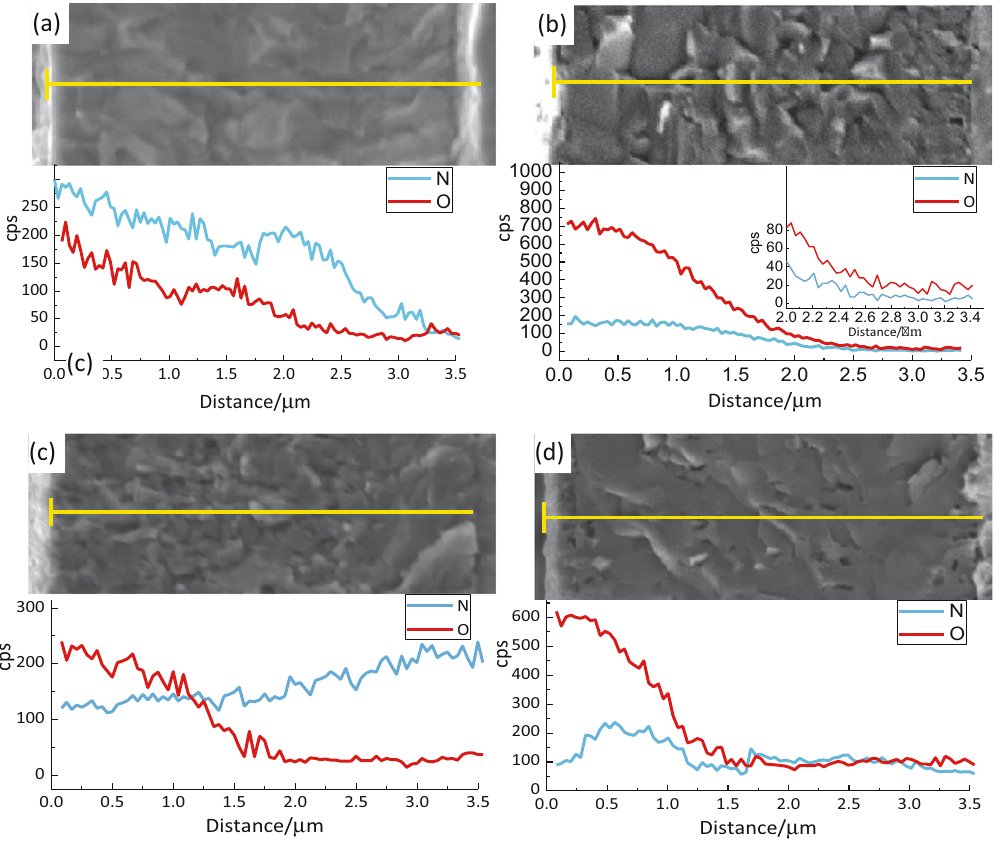
Figure 6: The di ff usion depth of nitrogen and oxygen at di ff erent temperatures: ( a ) coating A at 600°C, ( b ) coating A at 800°C, ( c ) coating B at 600°C and ( d ) coating B at